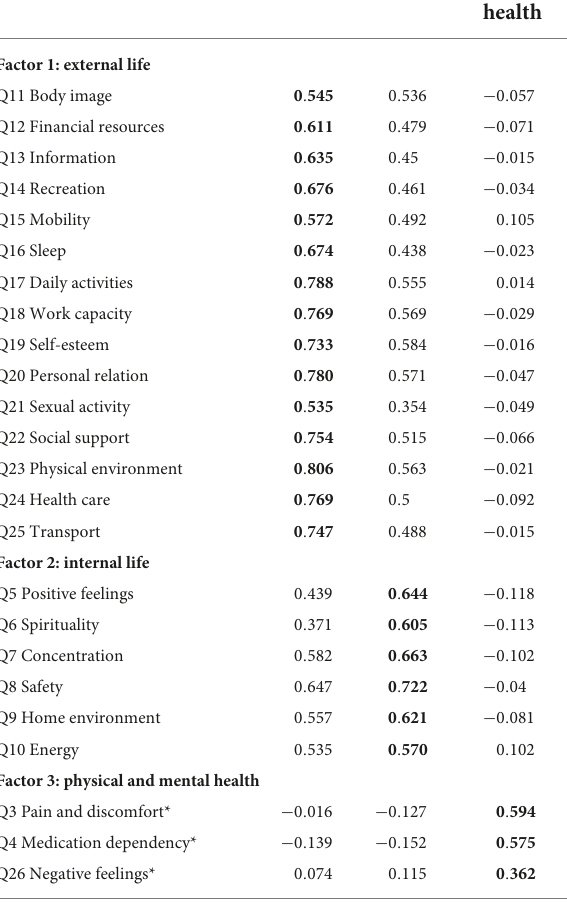
TABLE 5 Correlation matrix between items and domain scores to assess convergent and divergent